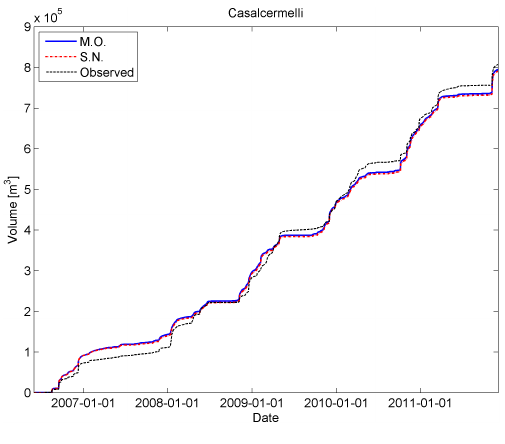
Figure 14. Accumulated runoff volumes for the Orba basin ob- tained with the M. O. and S. N. parameter sets for the period 2006– 2011. Time is reported on x axis and total accumulated volume on y